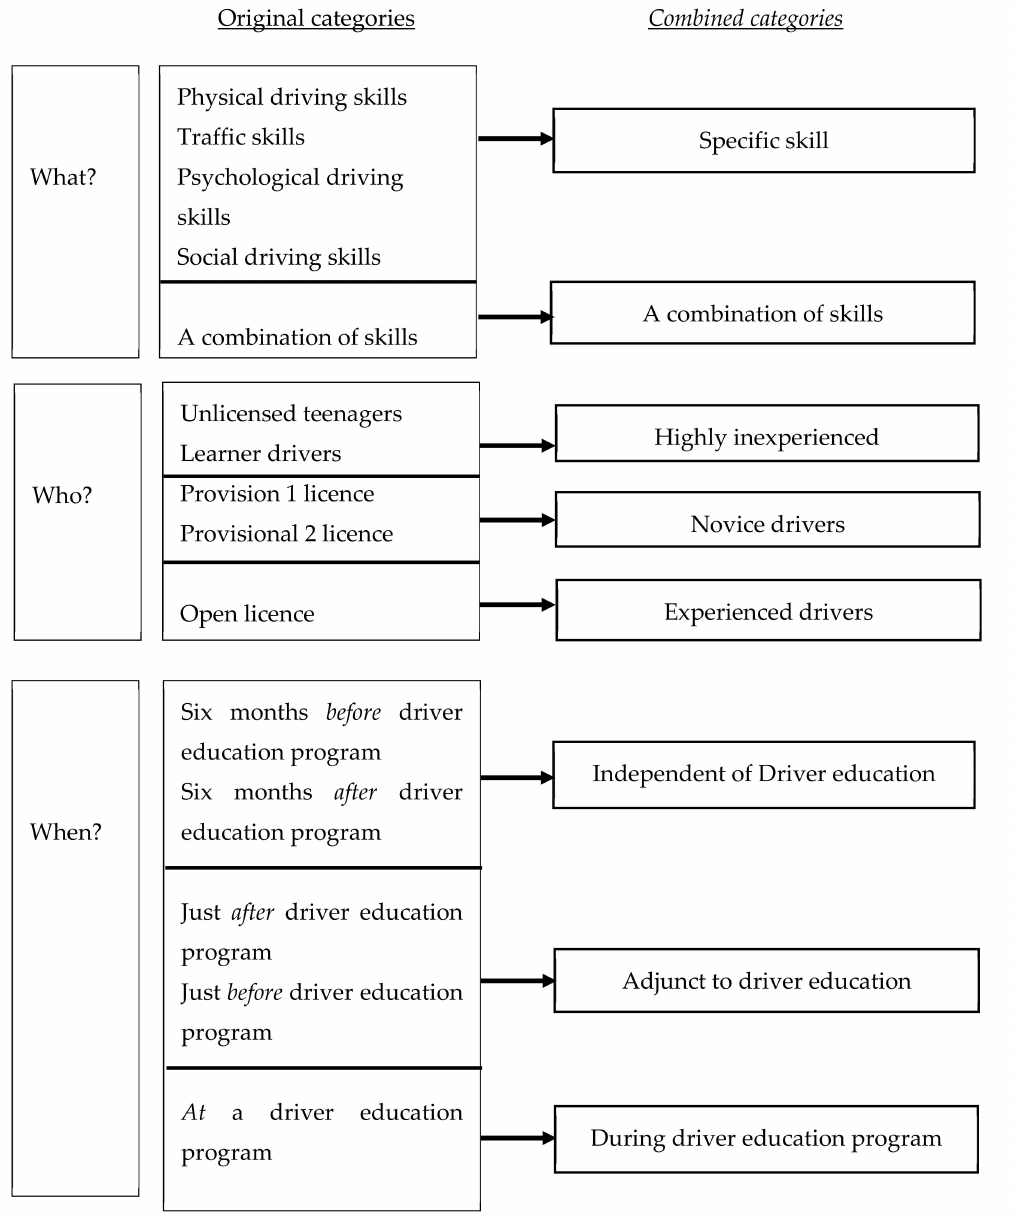
Figure 5. The combined “what”, “who”, and “when” subcategories. Percentage of young driver and parent responses indicating the target group that should be trained using a driving